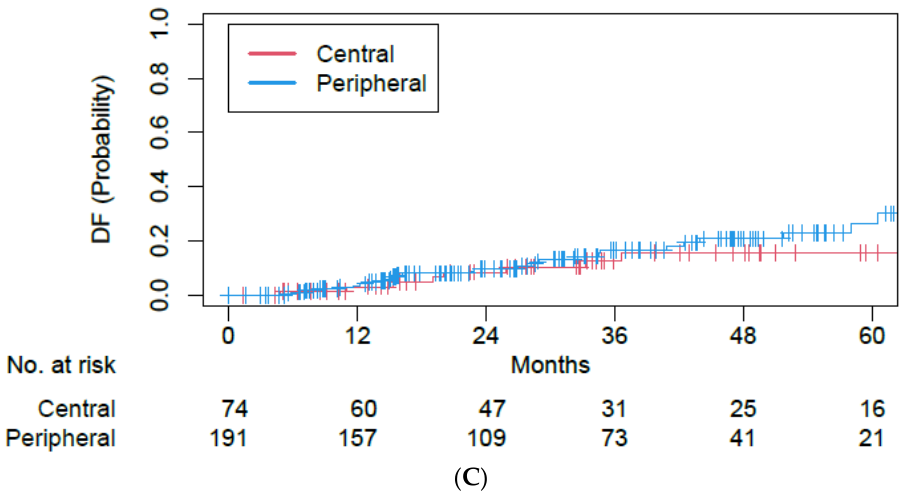
Figure 2. Cumulative incidence plots for ( A ) local failure, ( B ) nodal failure, and ( C ) distant failure outcomes among single- and five-fraction SBRT cohorts.